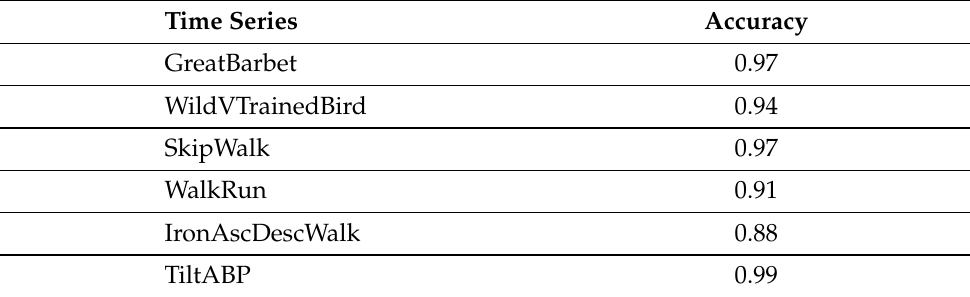
Table 3. Summarization accuracy of the PSF algorithm.